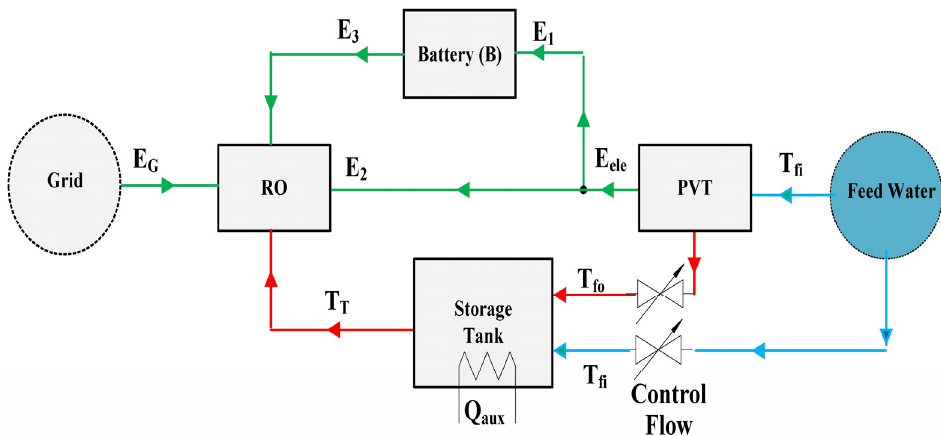
Figure 1. A scheme of PV thermal and RO-based operational setup for water desalination unit (T and E correspond to thermal and electrical energy, respectively) [59]. Image reused under the Creative Commons Attribution